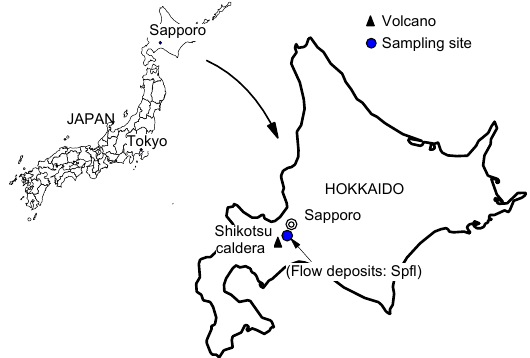
Figure 1. Location of sampling site in this study. Table 1. Physical properties of Spfl and Toyoura sand. Sample